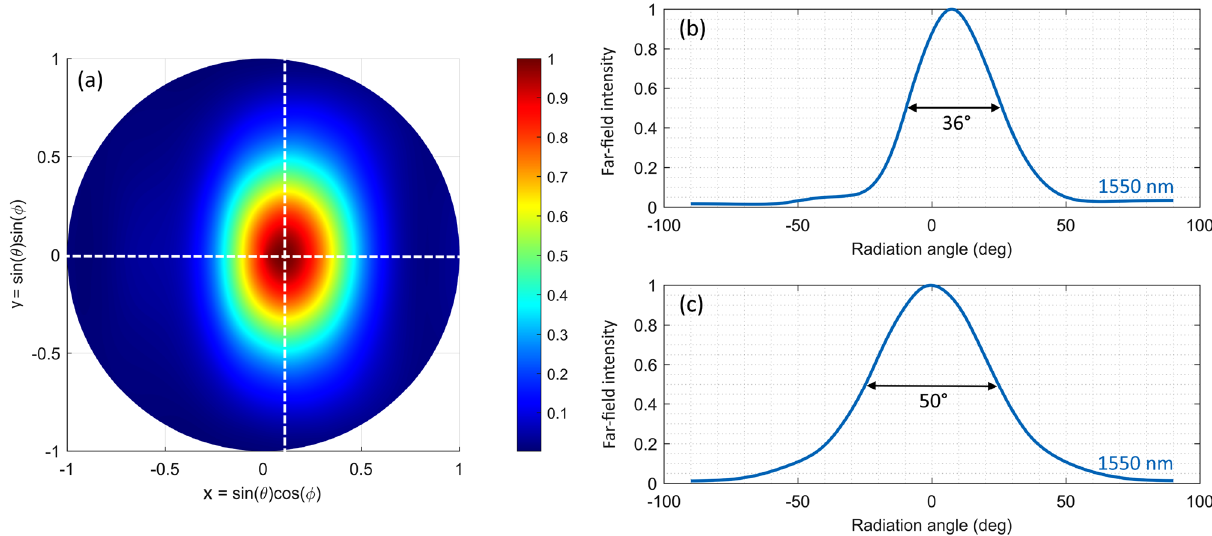
Figure 2. ( a ) The far-field radiation pattern of the reference antenna at a wavelength of 1550 nm. ( b ) Far-field intensity distribution along the x and ( c ) y axis, as marked by the dashed white lines in ( a